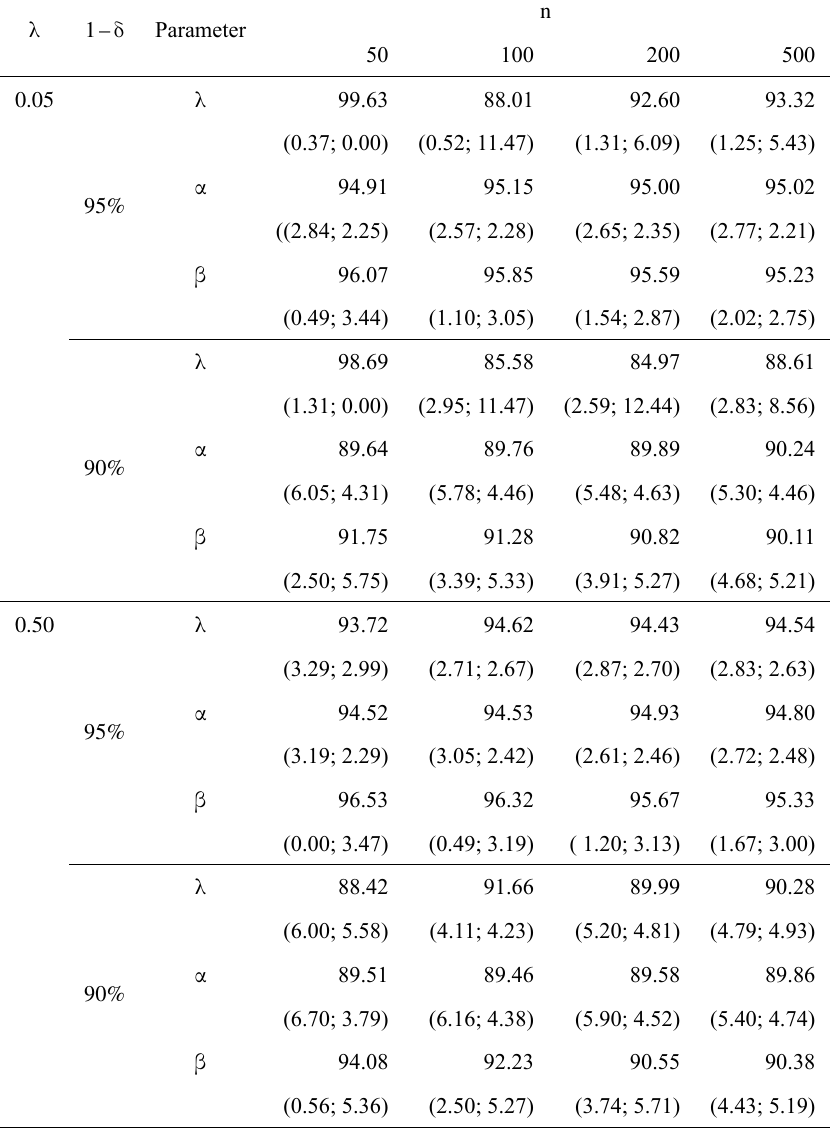
Confidence intervals empirical coverages and noncoverages (to the left; to the